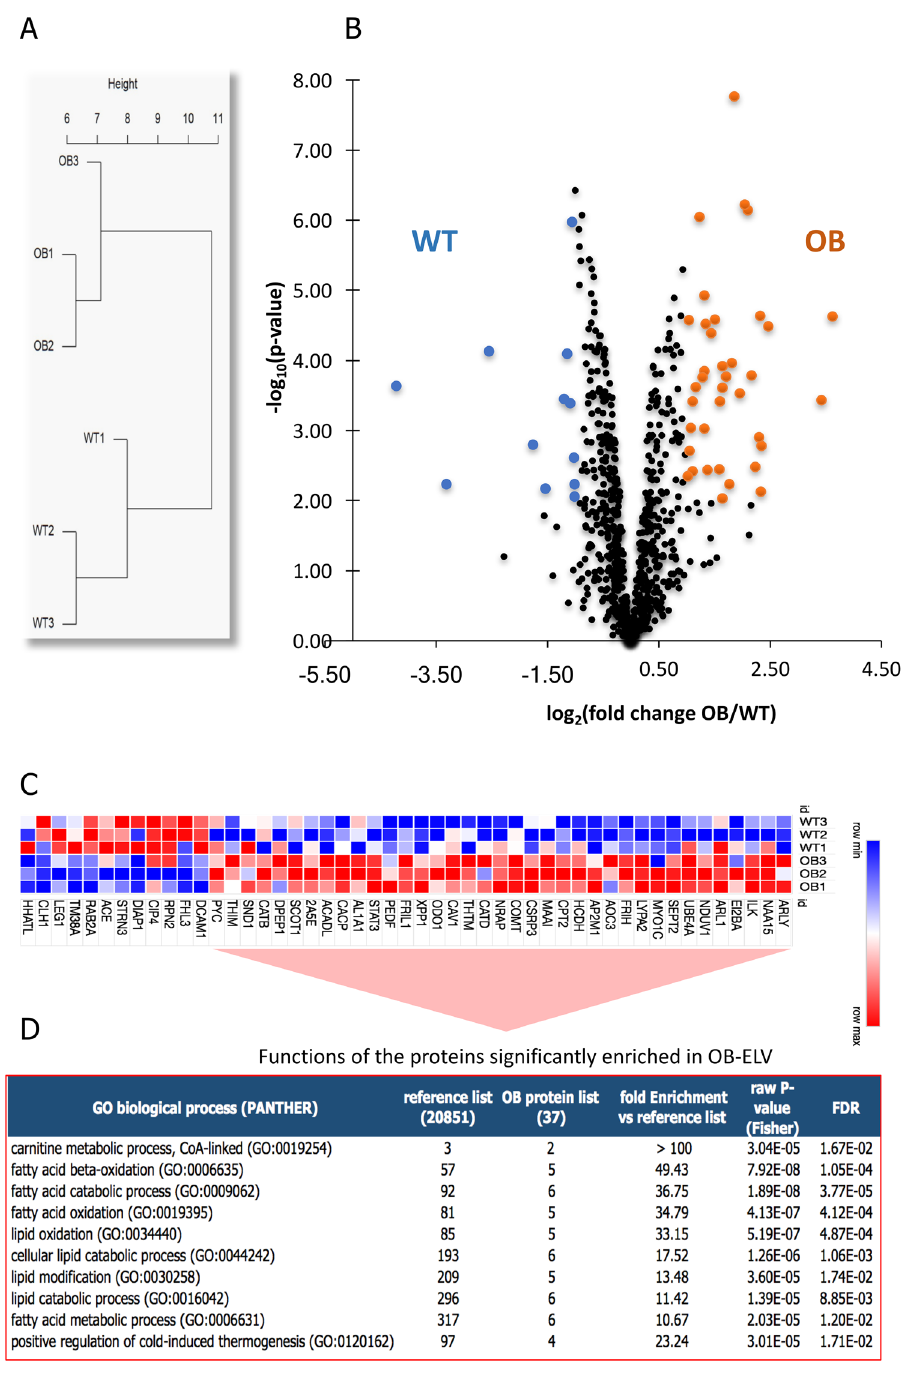
Figure 2. Impact of obesity on SkM-ELV protein profile. The full protein datasets are in Table S2. ( A ) Pie chart showing the intracellular localizations of the 798 SkM-ELV proteins. Only the significant pathways with more than 150 genes are shown. ( B ) Pie chart showing the significant GO metabolic pathways controlled by the 798 SkM-ELV proteins. Only the main significant metabolic pathways with more than 15 genes in the pathway are shown. Redundant pathways have been removed. ( C ) Clustering of the 798 SkM-ELV proteins, based on their abundance, in OB- and WT-ELVs. ( D ) Volcano plot showing statistical significance ( p -values) versus magnitude of changes (fold changes OB/WT expressed in log2). Red and blue dots represent proteins found more abundant in OB-ELVs and WT-ELVs, respectively ( p -value ≤ 0.01 and fold change ≥ 2). ( E ) Clustering focused on the subset of proteins differentially abundant in OB-ELVs vs WT-ELVs. ( F ) Significant Biological functions associated with the 37 proteins enriched in OB-ELVs vs